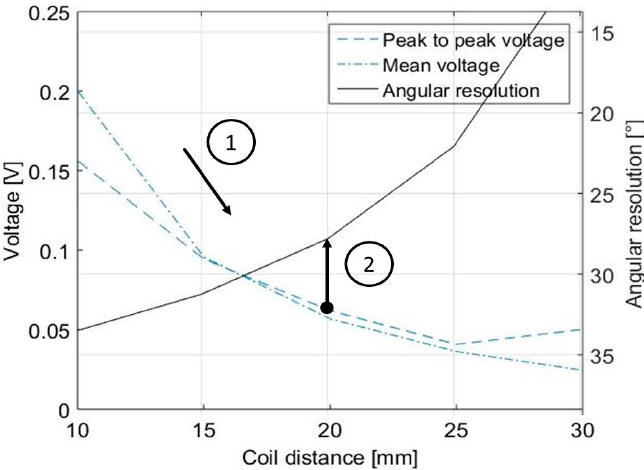
Figure 7. Material- and sensor-specific determination of possible angular resolution.